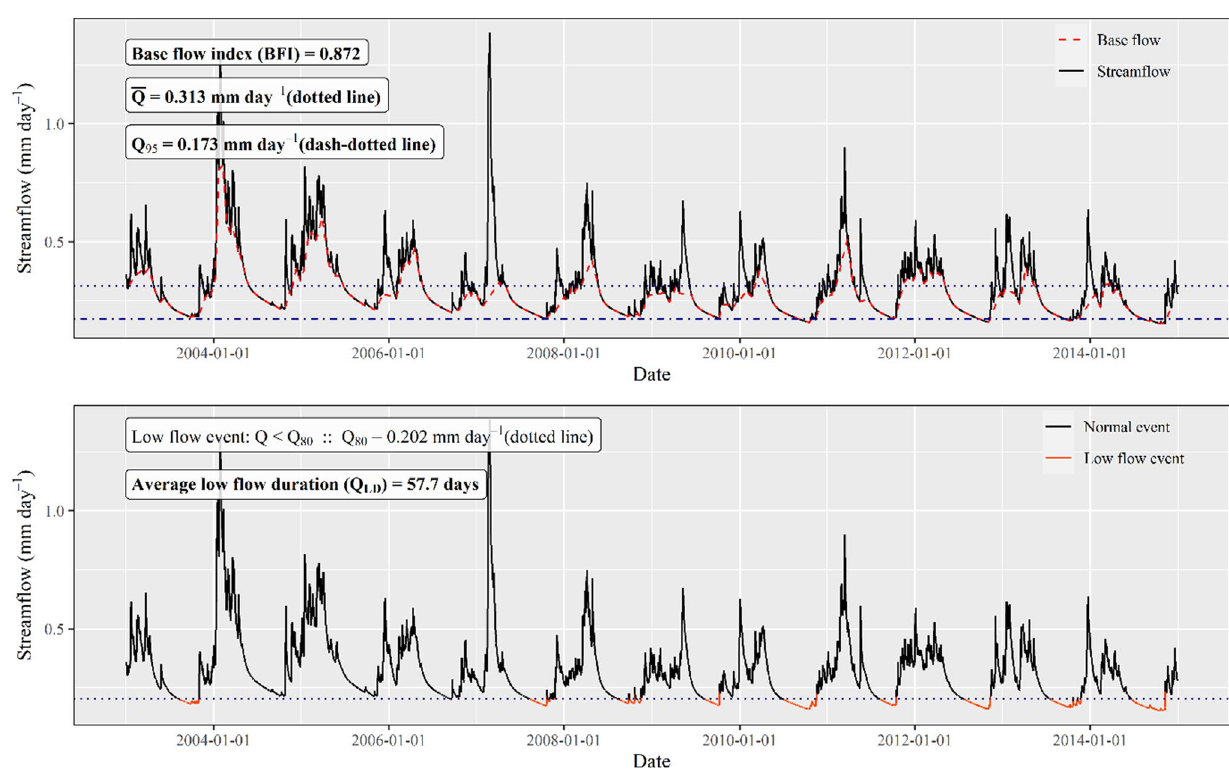
- Q = mean flow, Q 95 = 95th per-